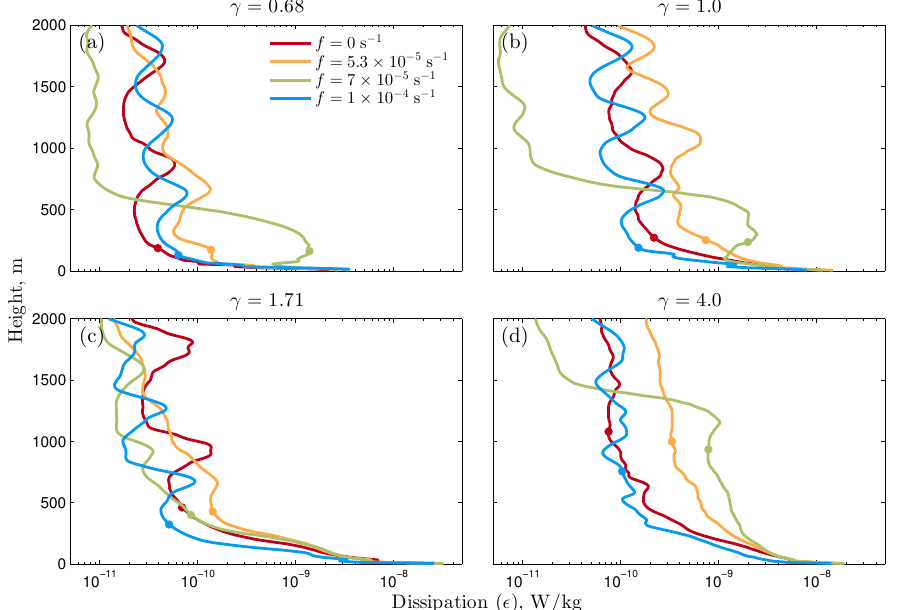
Figure 8. Vertical profiles of tidally- and horizontally-averaged dissipation, for four different values of γ , (a) γ = 0.68, (b) γ = 1.0, (c) γ = 1.71, (d) γ = 4.0, as a function of f , all at λ x = 6 km. The topographic height in each simulation is shown by the colored